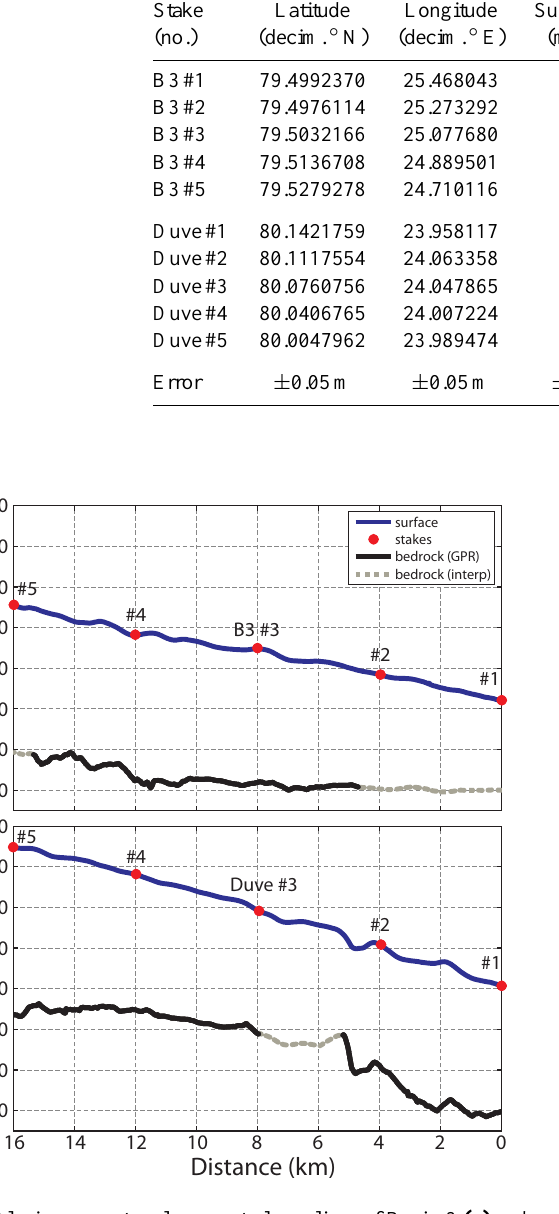
Fig. 2. Glacier geometry along central flowlines of Basin-3 (a) and Duvebreen (b) . Surface elevation (solid blue) in ma.s.l. is based on kinematic GPS measurements, GPR-derived ice thickness sub- tracted to yield bedrock elevation (solid black and dashed grey). Stake positions are marked with red dots. The lowermost stakes on both flowlines are located ∼ 5km upstream from the calving